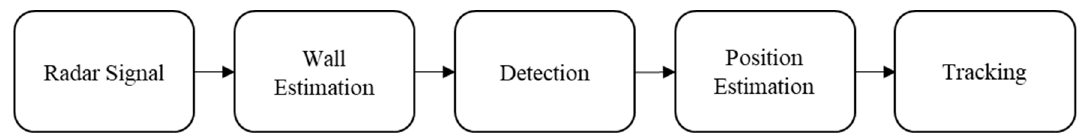
Figure 2. Half bow-tie quasi-Yagi antenna